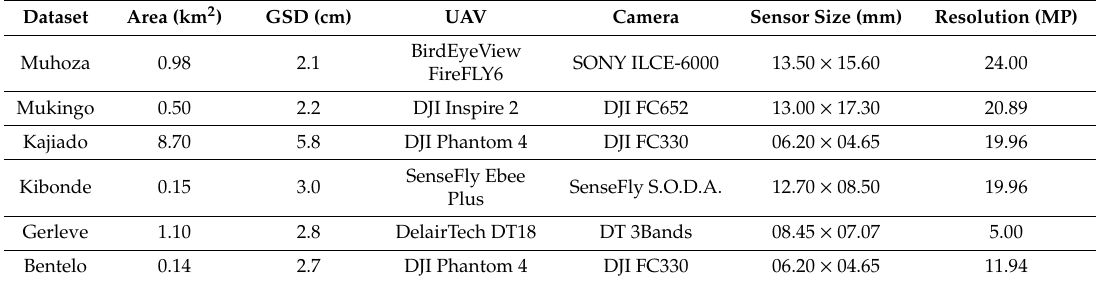
Figure 2. Overview of all datasets presented as orthomosaics ( a ) Bentelo, ( b ) Gerleve, ( c ) Mukingo, ( d ) Kajiado, ( e ) Kibonde, and ( f ) Muhoza (scales vary). Table 1. Unmanned Aerial Vehicles (UAVs) and technical specifications of the sensor. GSD refers to ground sampling